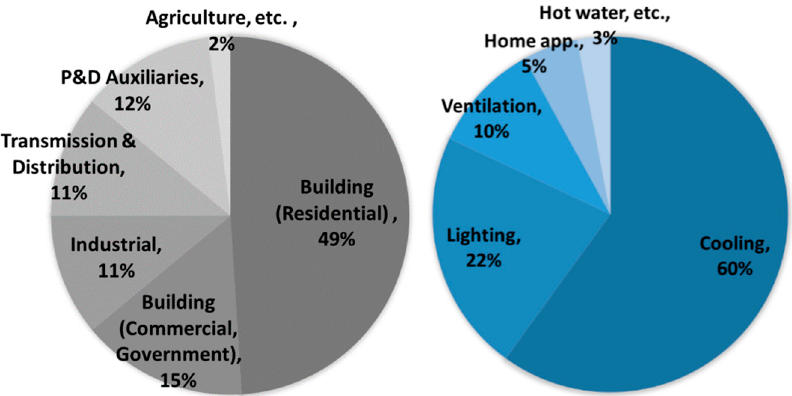
Figure 1. Energy consumption by type of building ( left ) and energy consumption in residences for specific purposes ( right ).